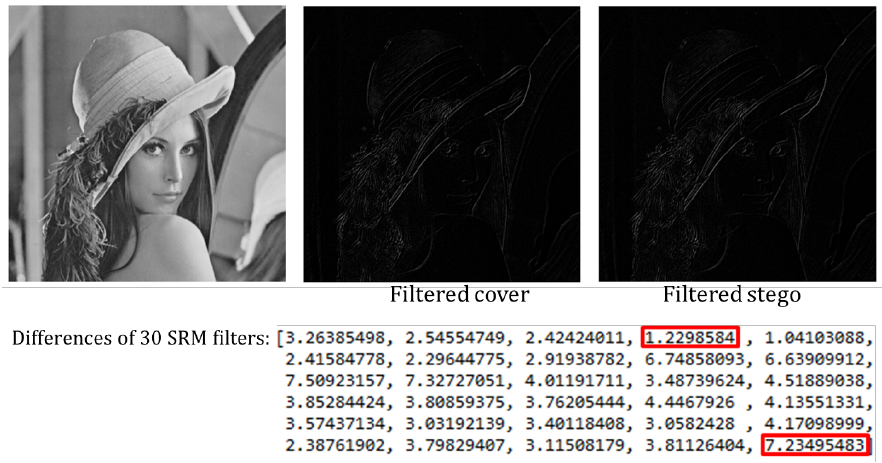
Figure 14. Selection of more effective SRM filters: a large difference (e.g., 1.229 and 7.234) depending on the filter between the filtered cover and stego images is found after each SRM filter is applied. Table 7. Ternary classification rates of the base CNN with different preprocessing filters ( bpp = 0.4).